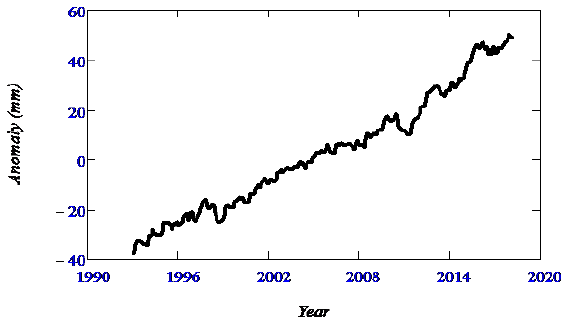
Fig. 1. Globally averaged mean mean sea level anomaly as observed by SA during 1993 – 2018 (GSFC,